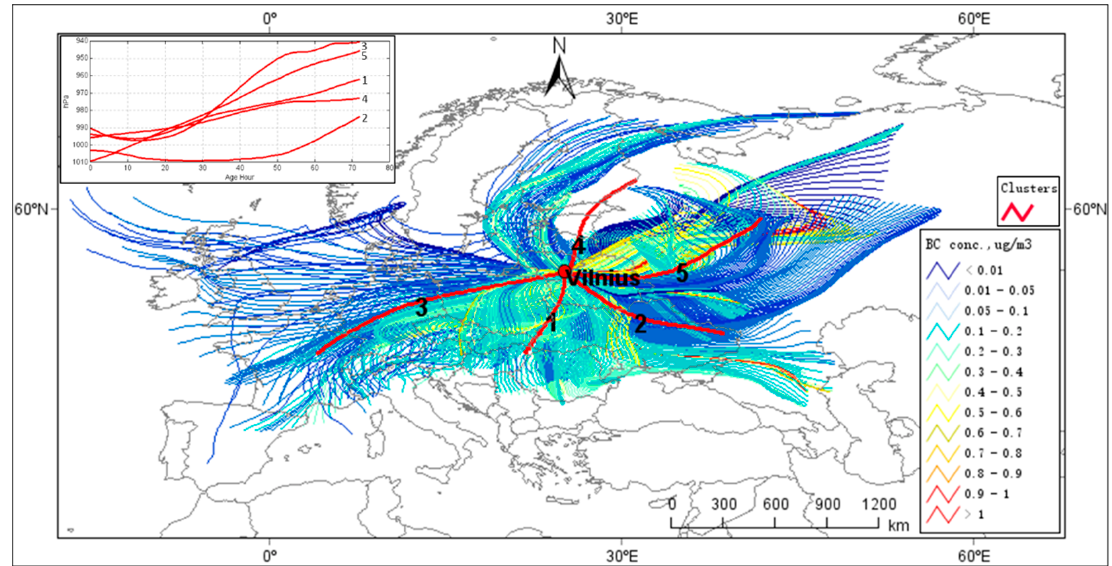
Figure 7. Air mass backward trajectories and clusters with associated BC mass concentration in January and February 2014.